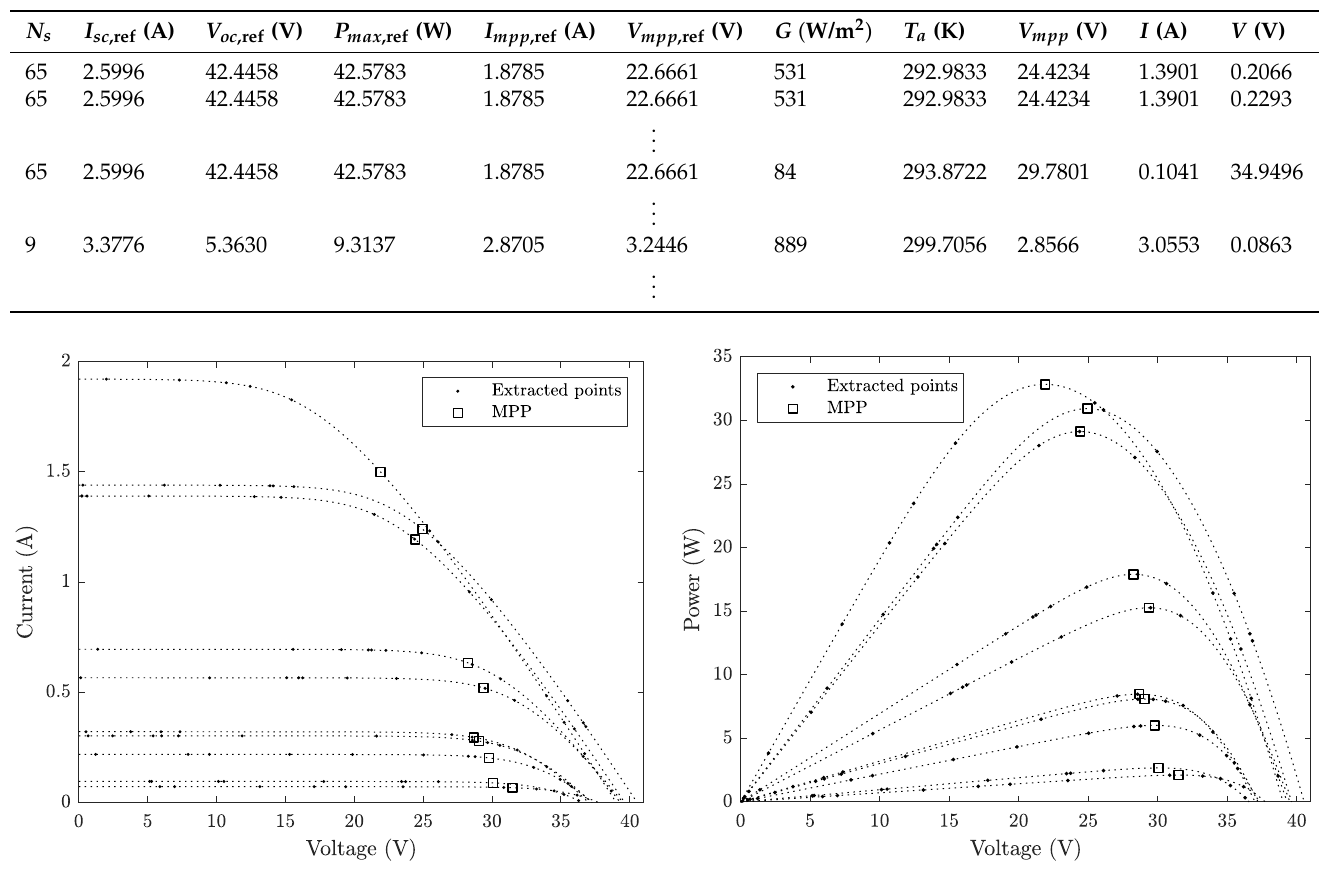
Table 1. Subset of the generated training data set.